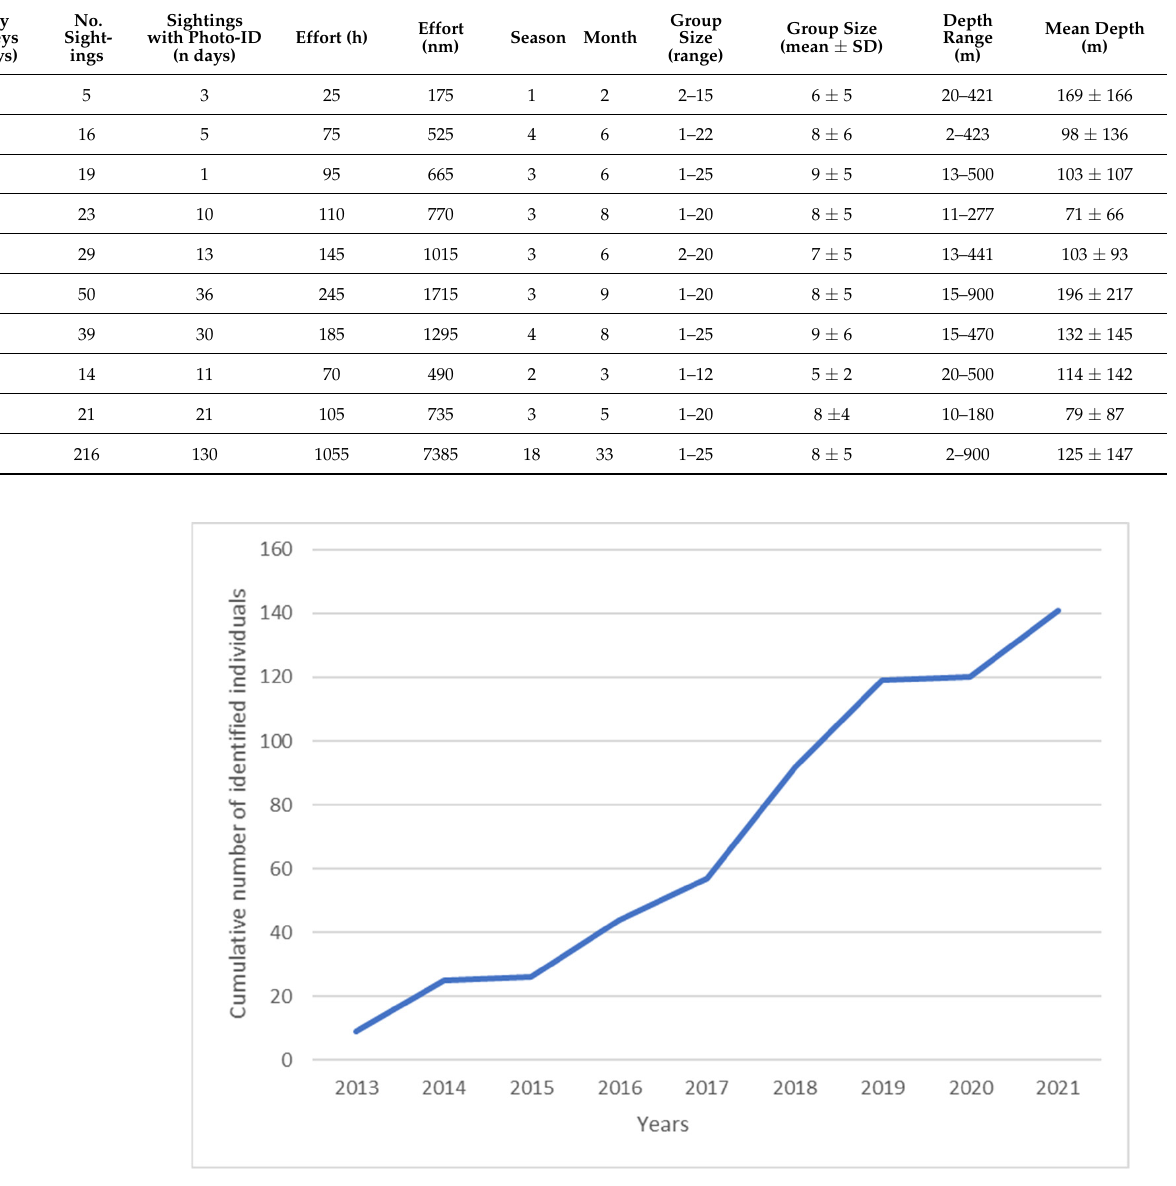
Figure 2. Cumulative number of identified individuals from 2013 to 2021 in the Gulf of Taranto. Once the quality and distinctiveness criteria were applied, it was possible to identify and catalog 141 specimens thanks to the natural marks and cuts or deformities on the edges of the dorsal fin. Among them, 34 individuals were sighted only once and 107 were re-sighted from 2 up to 31 times, with a mean value of re-sightings of 5 ± 5 times. In detail, 25 bottlenose dolphins were re-sighted in one year, 31 were observed in two or more consecutive years and 51 in two or more non-consecutive years. Sixteen dolphins were unequivocally sexed as female and none as